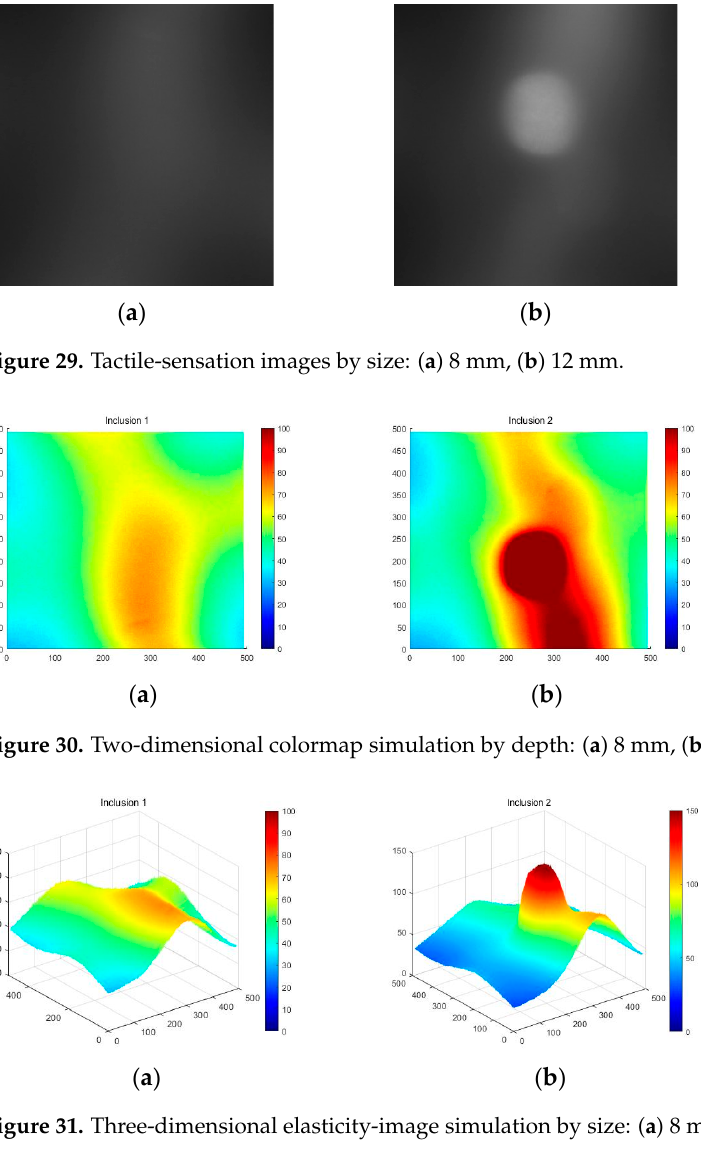
Figure 28. ( a ) Includes 12-mm tissues. ( b ) Includes 8-mm tissues.